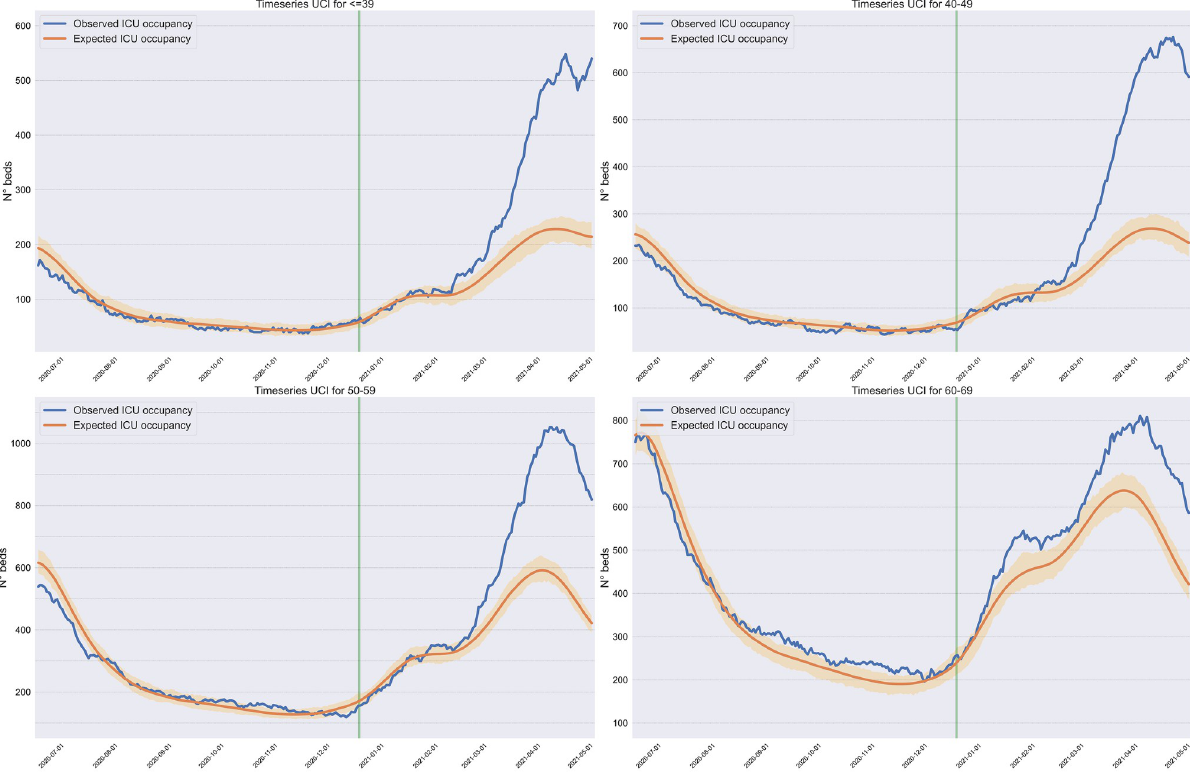
Fig 1. Actual and predicted (expected) ICU occupancy by age, 2020-model. The blue and orange curves depict the actual and predicted (using the 2020-model) ICU occupancy, and the shaded area represents the 95% confidence intervals for the predicted ICU occupancy. The green vertical line denotes the beginning of